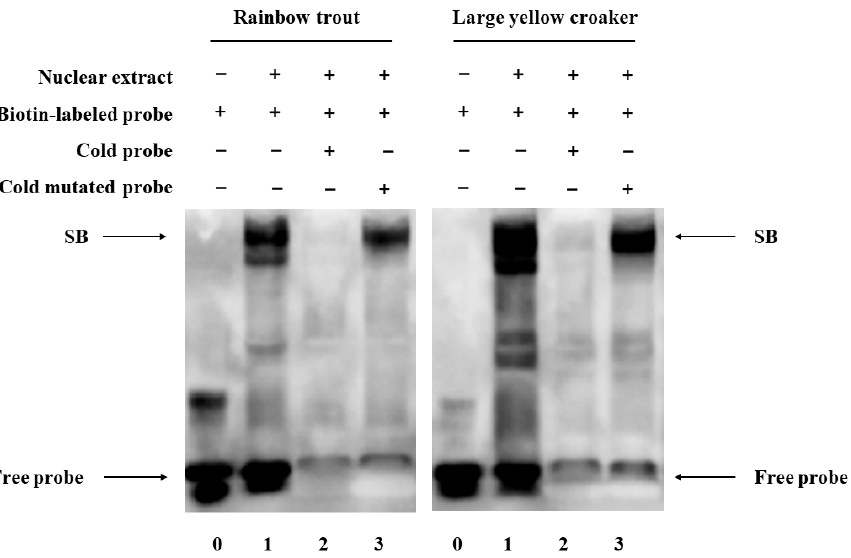
Figure 10. EMSA assay. EMSA assay to identify the binding of C/EBP α and fads2 promoter in rain- bow trout and large yellow croaker.”+” means present; “ − “ means absent.